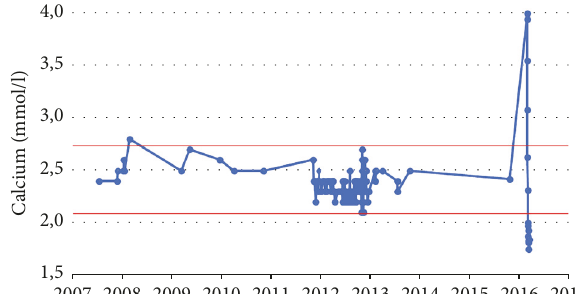
Figure 1: Patient’s serum calcium values over the years (since his initial cardiac disease in 2007) showed significant hypercalcemia during his fatal disease.